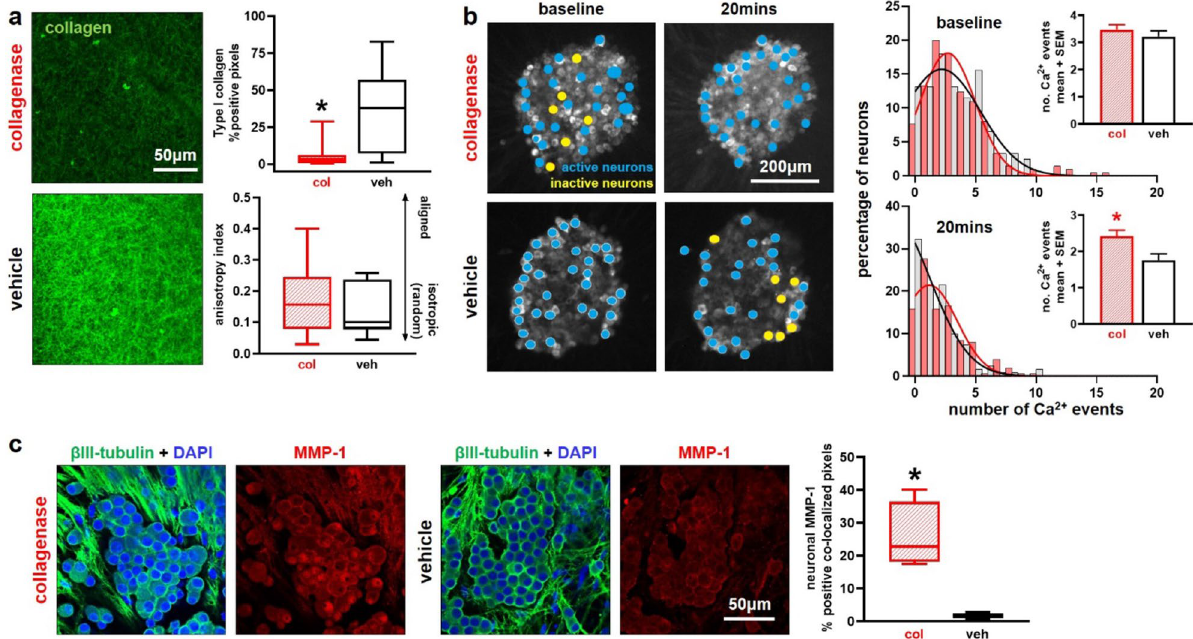
Figure 6. Effects of collagenase exposure on the collagen network and neuronal dysregulation in an in vitro co-culture model mimicking the capsular ligament. ( a ) Type I collagen labeling (green) after a 20 min collagenase (col) incubation (n = 4 gels/group; n = 4 images/gel) is significantly reduced from levels with vehicle (veh) exposure (Wilcoxon test; *p = 0.008); in contrast, fiber orientation is unchanged with collagenase exposure (two-tailed t-test; p = 0.380). ( b ) Time-lapse captures of fluorescent calcium imaging show DRGs with segmented individual neurons labeled as active (blue; ≥ 1 calcium events) or inactive (yellow; no calcium events) in images from both before the addition of either collagenase (7 DRGs) or vehicle (4 DRGs) solution and after 20 min of exposure. Neuronal firing profiles captured across 28–33 neurons/DRG are the same in both groups at baseline (Wilcoxon test; p = 0.562), shown by frequency distributions of the percentage of neurons versus the firing magnitude per minute. Summary data in the bar plot also show no difference in number of calcium events at baseline. However, firing frequency patterns differ with treatment after 20 min, with vehicle-exposed neurons quieting as shown by a left-shift of the frequency curve peak toward zero and the summary data detailed in the bar plot (Wilcoxon test; *vs. vehicle p = 0.002). ( c ) Collagenase exposure increases neuronal MMP-1 expression (collagenase n = 4 gels; vehicle n = 2 gels; Wilcoxon test; *p < 0.001) quantified by the co-localization of the neuronal structural protein βIII-tubulin (green) and MMP-1 (red); a DAPI label for nuclei is also shown (blue). Images show the maximum projection image of acquired confocal stacks (n = 5/gel) in regions with DRG axons and/or soma. Box-and-whisker plots in ( a ) and ( c ) show horizontal lines representing the first (lower) quartile, median, and third (upper) quartile of the data; whiskers are the minimum and